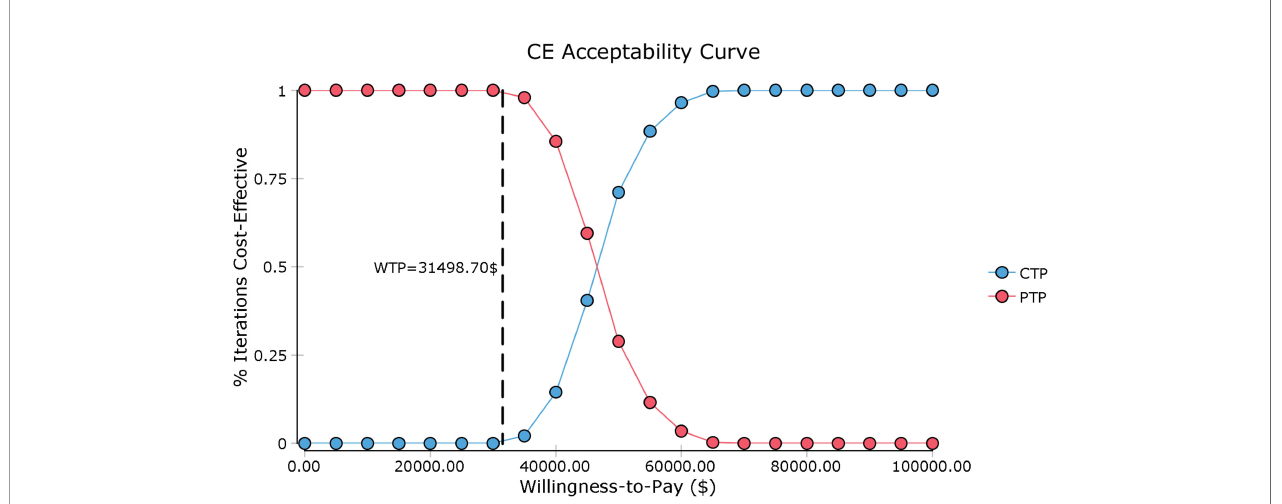
FIGURE 4 | Cost-effectiveness acceptability curve. CE, cost-effectiveness; CTP, camrelizumab-chemotherapy; PTP, placebo-chemotherapy; WTP, willingness-to-pay.